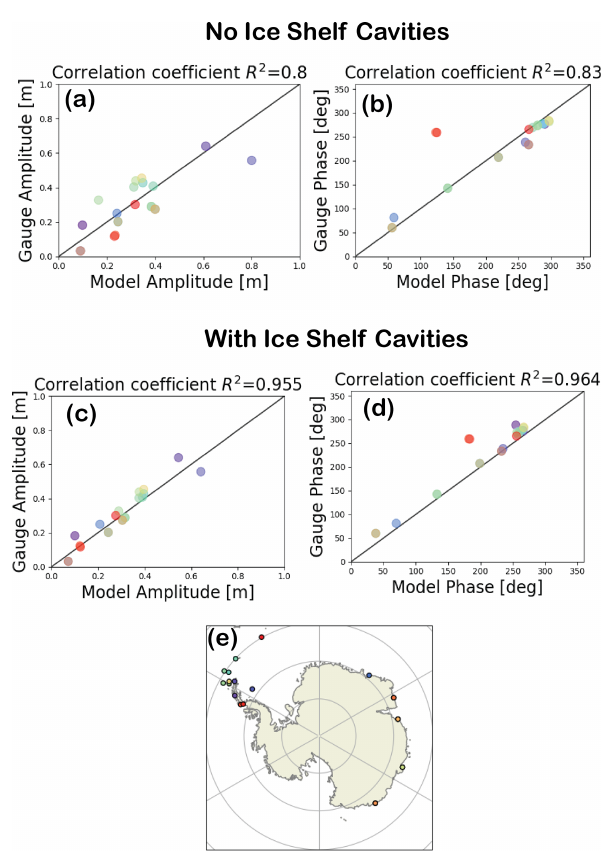
Figure 7. Tide gauge comparison between the variable-resolution model simulation (horizontal axes) and observations (vertical axes) for M 2 amplitude (a, c) and M 2 phase (b, d) , where the simulation is without ice shelves (VR n , a, b ) and with ice shelves (VR is , c, d ). These tide gauges are near the Antarctic coast and Drake Pas- sage (e)